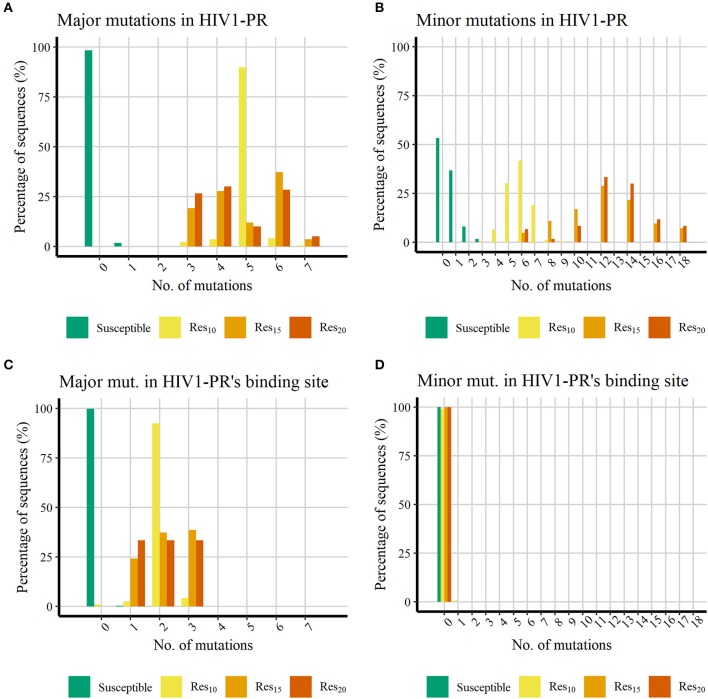
Histograms representing the percentage of PI-resistant mutations in the datasets showing increasing number of PI-resistant mutations in the datasets retrieved from HIVDB. (A) Percentage of major mutations in the whole HIV1-PR. (B) Percentage of minor mutations in the whole HIV1-PR. (C) Percentage of major mutations in the HIV1-PR binding site. (D) Percentage of minor mutations in the HIV1-PR binding site. Represented datasets: [Susceptible] (green); [Res10] (yellow); [Res15] (orange); [Res20] (dark orange).